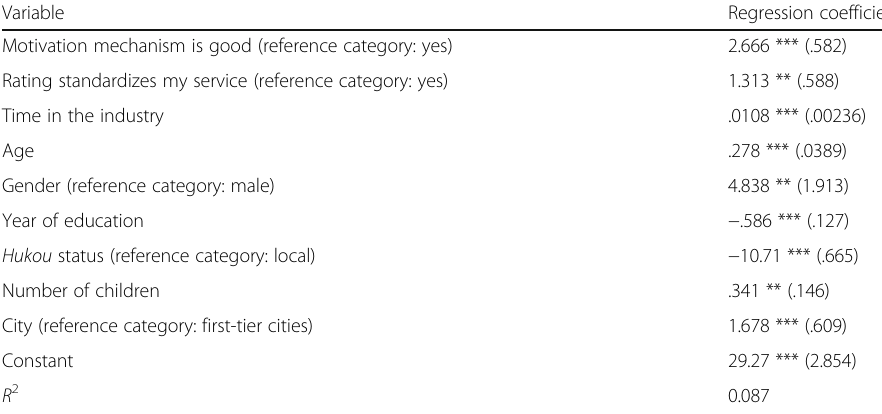
Table 4 Regression results: full-time drivers N = 5335 Variable Regression